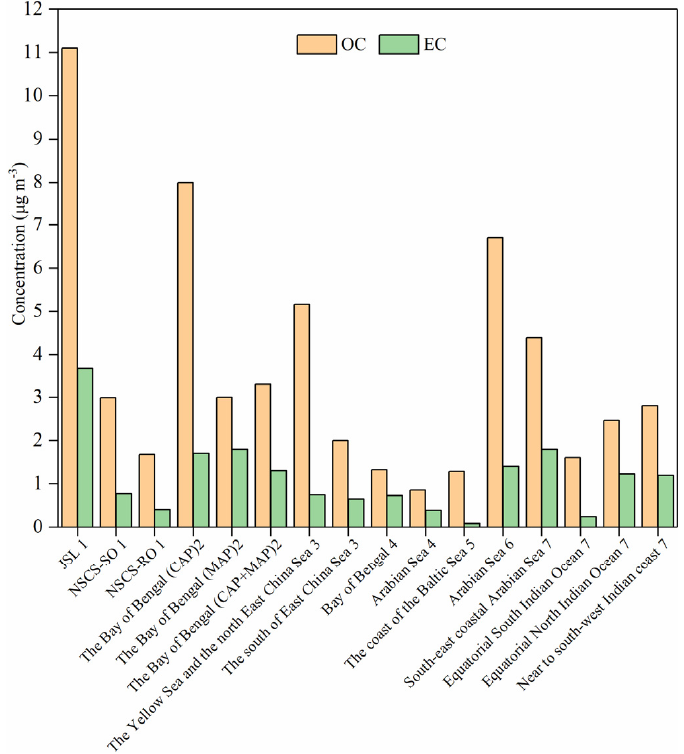
Figure 2. Comparison of average concentrations of OC and EC in ocean aerosol from different sampling locations (1 this study; 2 Nayak et al., 2022 [30]; 3 Yu et al., 2022 [32]; 4 Budhavant et al., 2018 [35]; 5 Milukaite et al., 2007 [36]; 6 Bikkina et al., 2020 [37]; 7 Aswini et al., 2020 [31]).